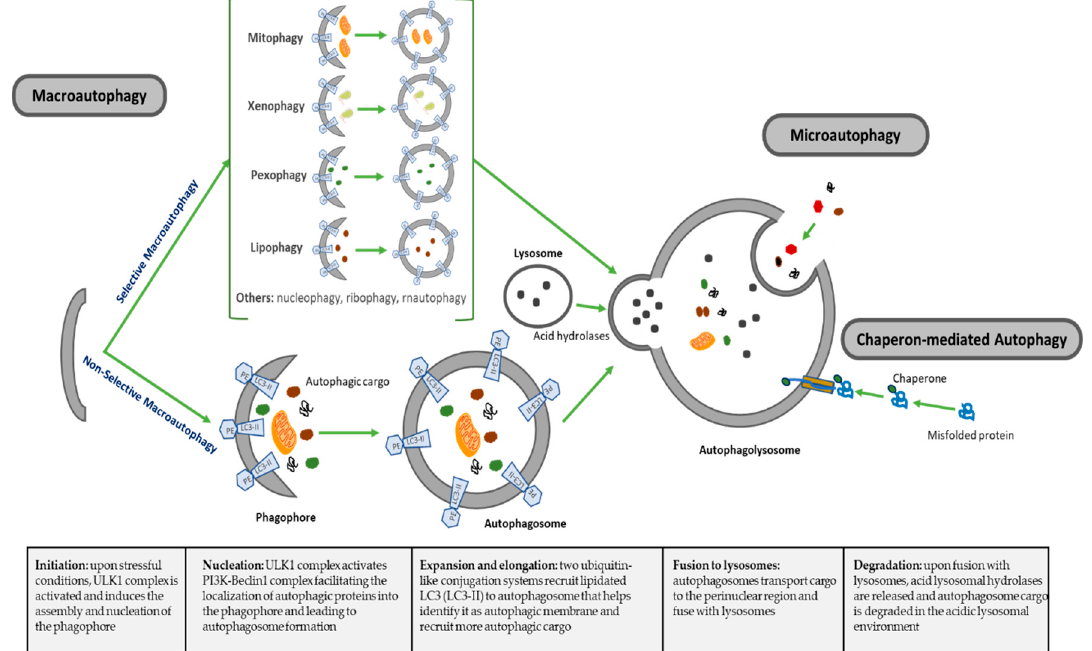
Figure 1. Schematic illustrating distinct types of autophagy. Intracellular components can enter the lysosome for degradation mainly by three autophagic pathways. 1) Macroautophagy: proteins, organelles and other cytosolic components are sequestered in a de novo-formed isolation membrane that expands and seals to form a double-membrane-bound vesicle, the autophagosome. Degradation occurs when autophagosomes fuse with lysosomes. Macroautophagy can be further subdivided into non-selective macroautophagy, where cytoplasmic components are engulfed into autophagosomes in a bulk manner; and selective macroautophagy, where distinct substrates (aggregate proteins, organelles or cellular components) are selectively targeted for degradation, giving rise to di ff erent types of selective autophagy depending on the autophagosomal cargo. 2) Microautophagy: invaginations at the surface of the lysosome or late endosomes trap cytosolic material, including proteins, and are then internalized after membrane scission and degraded in the lumen of the organelle. 3) Chaperone-mediated autophagy: soluble cytosolic proteins containing a targeting motif are recognized by the cytosolic chaperones which deliver the substrate to the membrane of the lysosome mediated by specific lysosomal-membrane bound receptors. The substrate protein unfolds and crosses the lysosomal membrane through a multimeric complex where it is degraded in the lysosomal